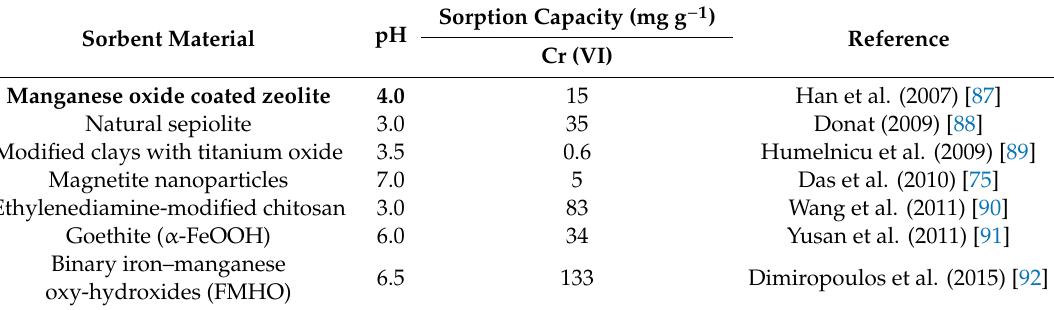
Table 6. Comparison of sorption capacities between various sorbents towards the removal of U(VI) ions. Sorbent